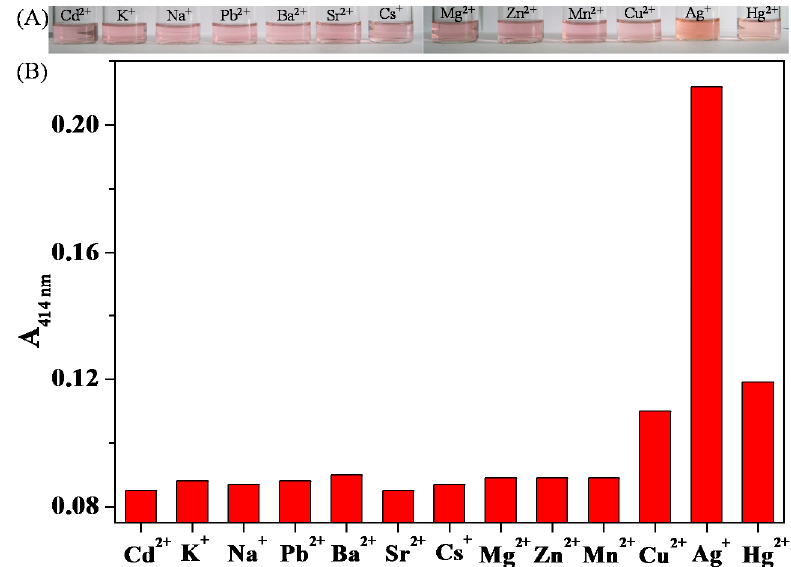
Figure 10. Selectivity of the sensor: ( A ) photographs and ( B ) response ( A 414 nm ) of 0.49 nM HPEI-IBAm-AuNPs solution in the presence of various metal ions at the concentrations of 57.3 µM.